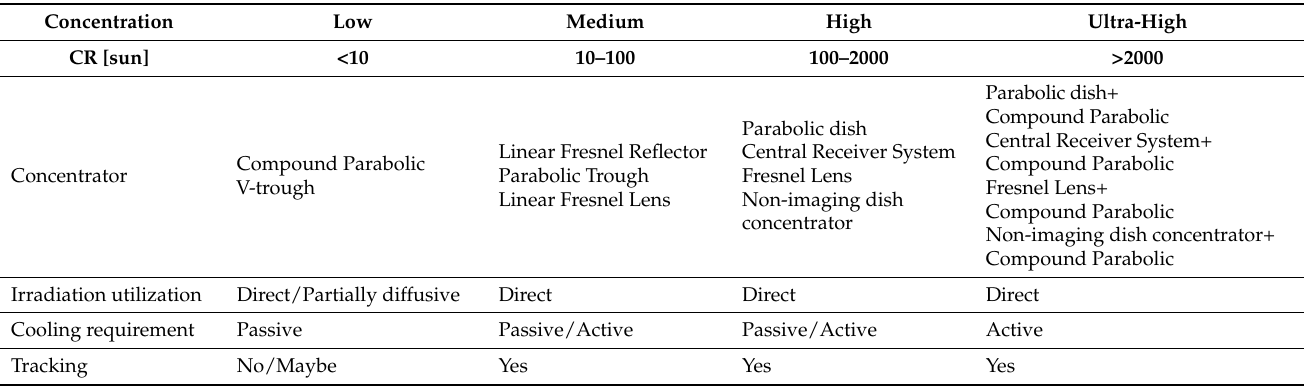
Table 2. CPVT classification based on concentration ratio. Prepared on the basis of